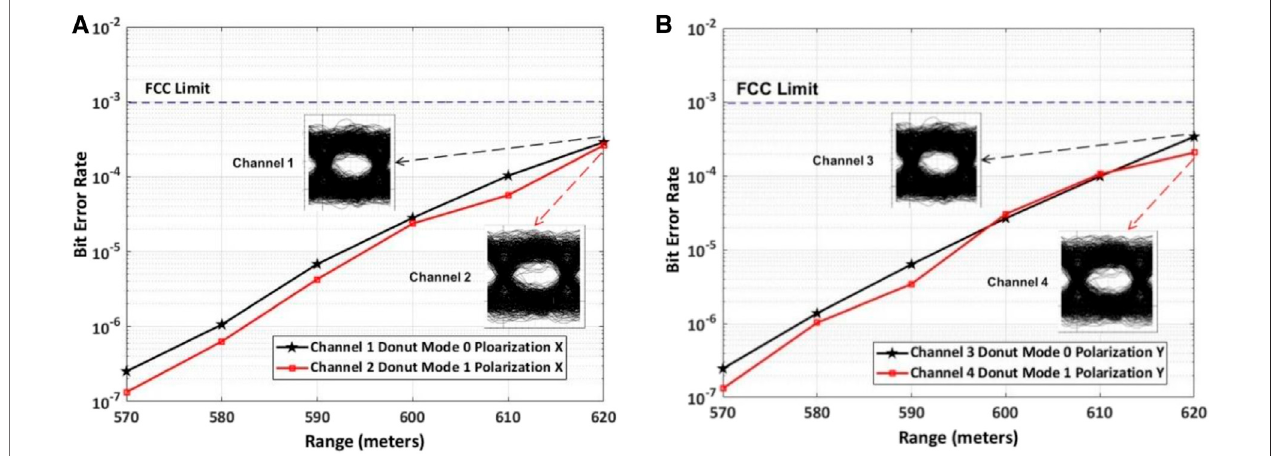
FIGURE 8 | Computed BER (dense fog/very hazy atmospheric conditions) (A) Channel 1 and Channel 2 (X Polarization) (B) Channel 3 and Channel 4 (Y Polarization).